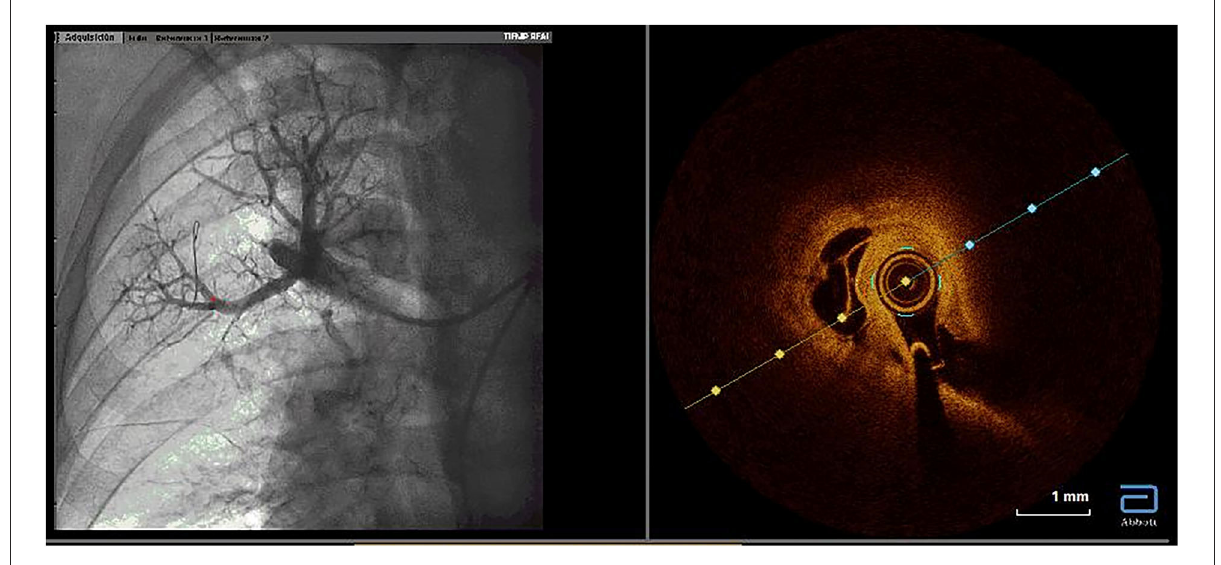
FIGURE2 Utility of optical coherence tomography to confirm CTEPH organized thrombi inside pulmonary arteries. Organized thrombi inside one segmental branch of the upper right lobe. CTEPH, chronic thromboembolic pulmonary hypertension.